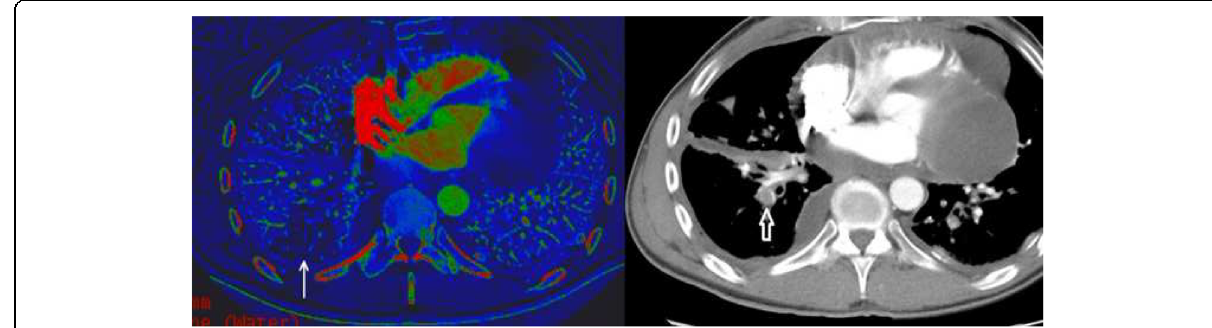
Fig. 21 Dual energy CT in a patient with pericardial and pleural metastases, with a PE. Iodine map is shown with perfusion defect (white arrow). This is correlated to the region with the PE in the right lower lobe (open white arrow)